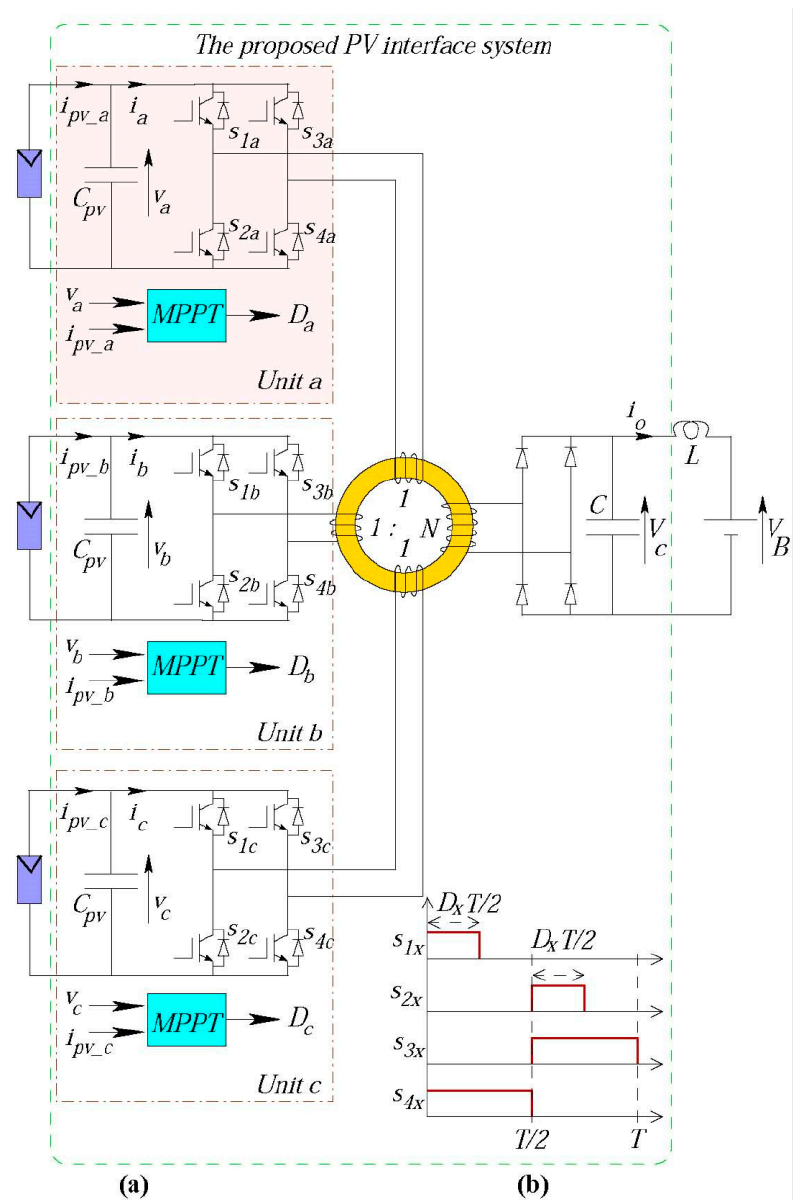
Figure 1. Proposed HFMP DC-DC converter for the PV interfacing system. ( a ) MP DC-DC converter. ( b ) Gating signals for the proposed MP DC-DC